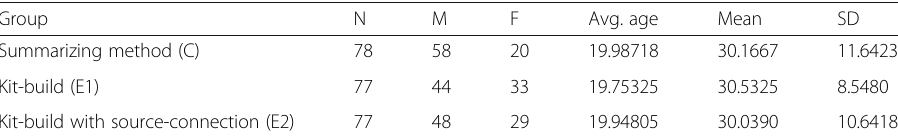
Table 1 Mean of the pre-test score Group N M F Avg. age Mean SD Summarizing method (C)